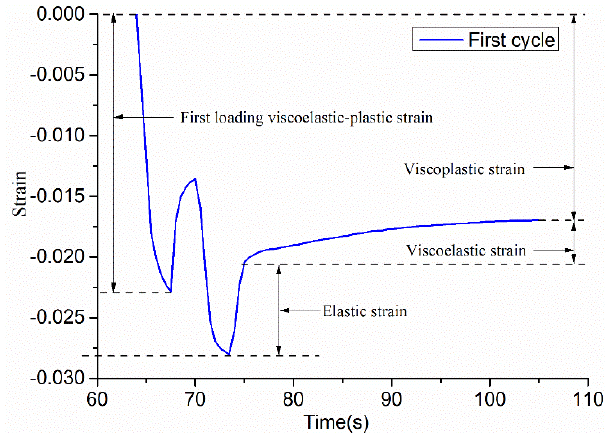
Figure 7. The first cycle strain – time curve of SAC-13.